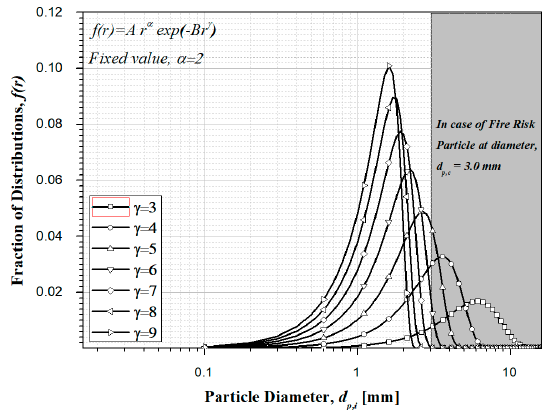
Figure 9. The results of the distribution of the particles for α = 2 and γ = 3, 4, 5, 6, 7, 8, and 9.